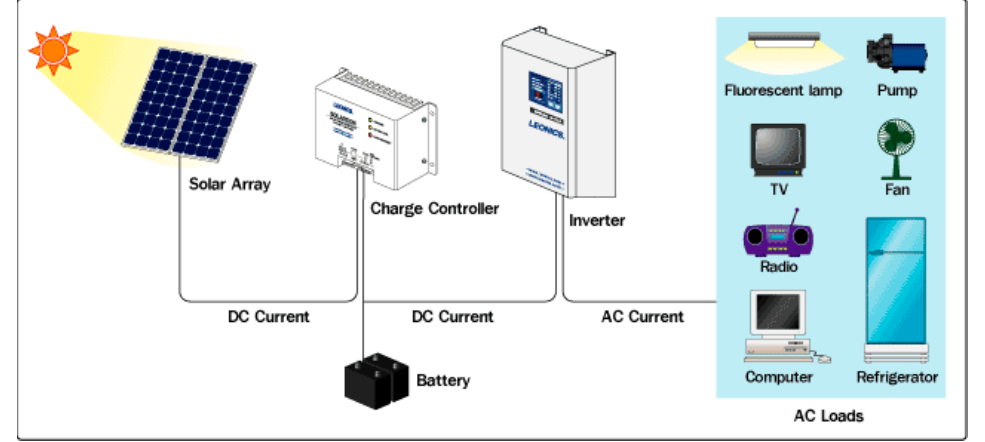
Figure 3. Typical solar home system [21].